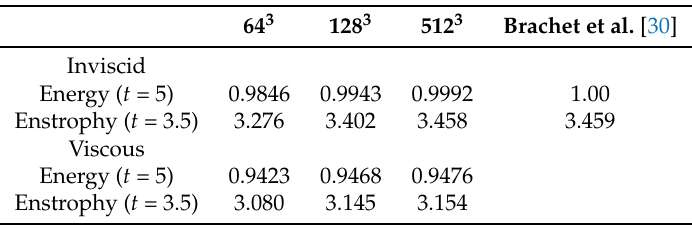
Figure 9. Evolution of Taylor–Green vortex. Curves are from simulations on grids of 512 3 ( black ), 256 3 ( blue ), 128 3 ( green ), and 64 3 ( red ) points. ( a , b ) Inviscid case with symbols from [30]; and ( c , d ) viscous case with solid line, present LES and symbols from [31]. Table 2. Measures of Taylor–Green vortex